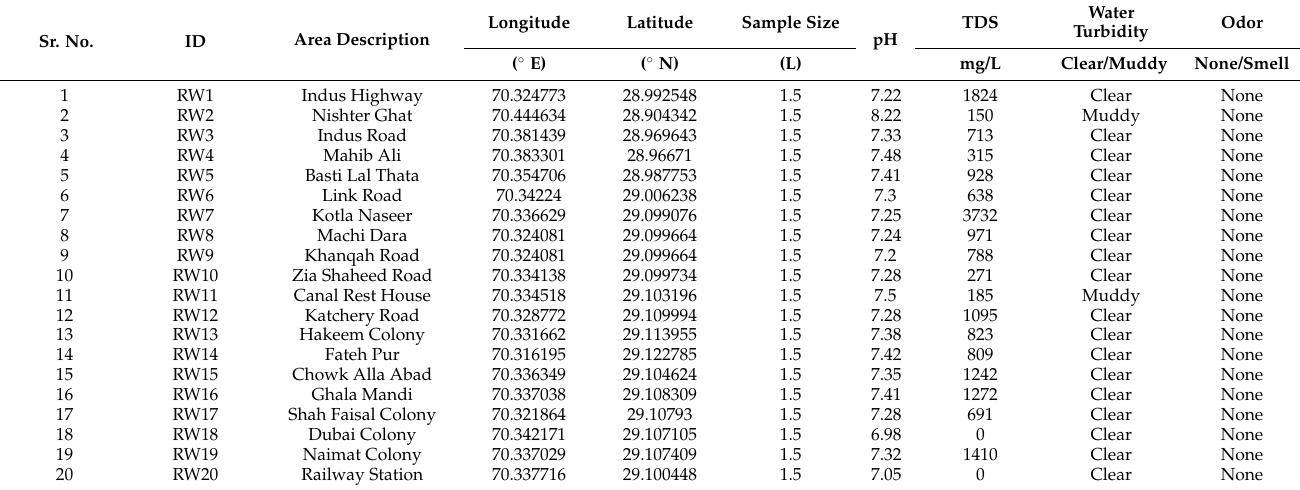
Table 2. Statistical summary of the physical parameters measured in the